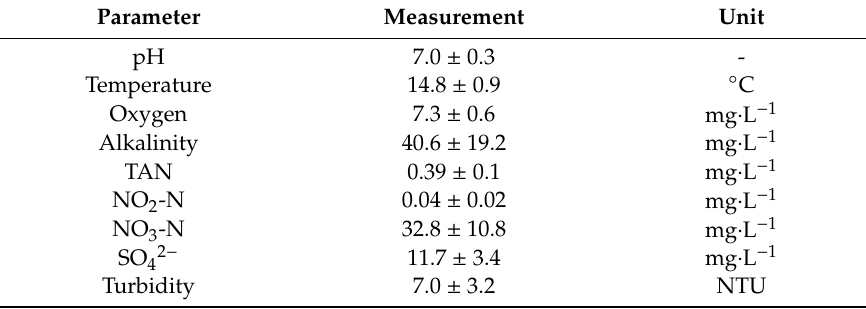
Table 1. Water quality parameters ( ± range) in RAS rearing rainbow trout (Oncorhynchus mykiss) and European whitefish (Coregonus lavaretus).